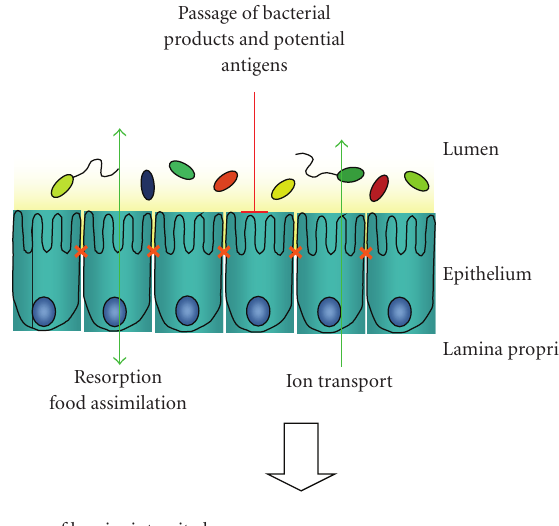
Figure 1: The intestinal epithelial barrier. The human gastrointestinal tract contains myriads of microorganisms. From oral to anal the number of bacteria is increasing tremendously. Especially the colon and the colonic epithelial cells are challenged by a heavily and continuous exposure to bacteria and antigens. The healthy epithelium represents a highly selective barrier that separates the body, especially the cells of the intestinal immune system, from the gut content. Therefore, it inhibits the passage of bacterial products and potential antigens and regulates the nutrient uptake as well as the resorption and secretion of ions and water. The integrity of the intestinal epithelium is maintained by a tightly controlled orchestra of regulatory mechanisms, such as the secretion of mucus, the production of defensins and cytokines, or intercellular